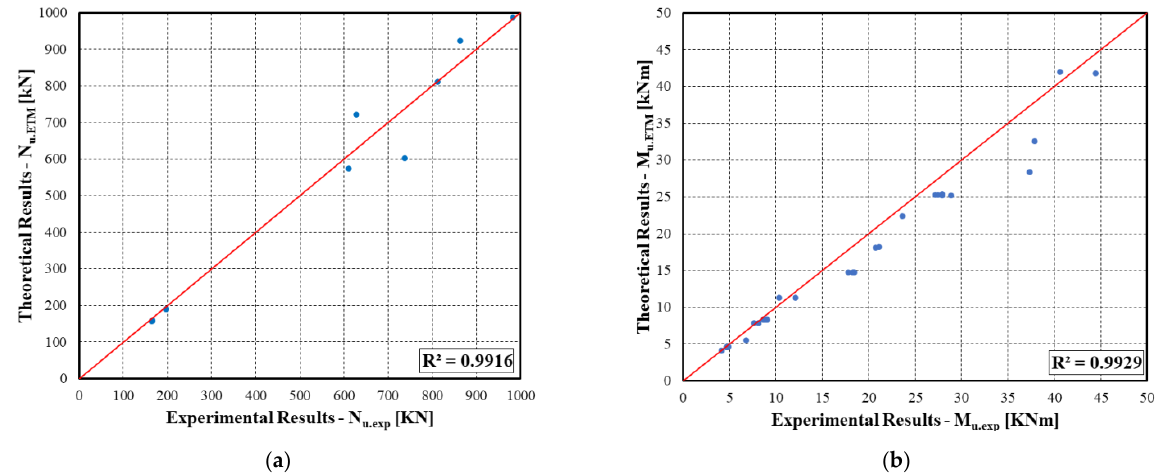
Figure 6. Comparison between theoretical and experimental results in the case of uniform compression ( a ). Comparison between theoretical and experimental results in the case of non-uniform bending ( b ).